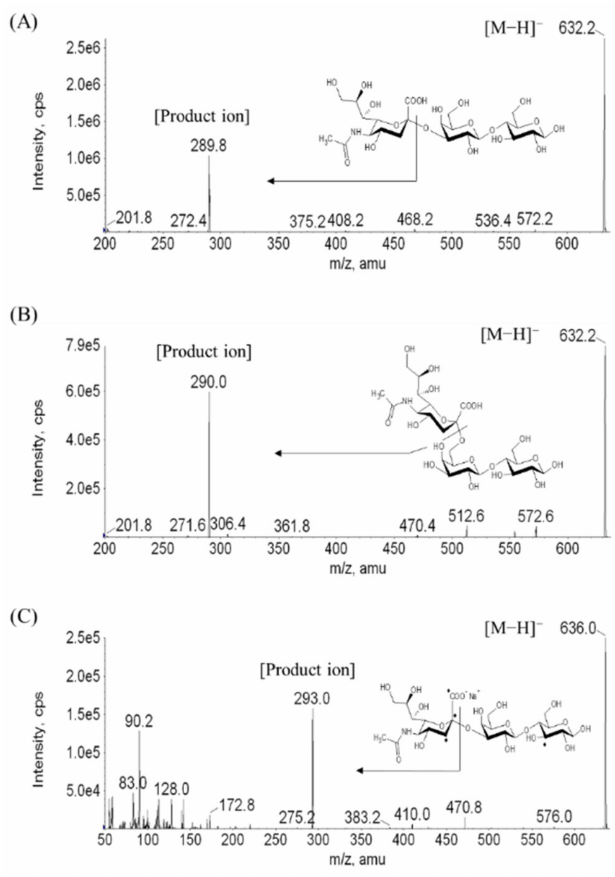
Figure 2. Molecular structure and product-ion scan spectra of ( A ) 3 (cid:48) -SL, ( B ) 6 (cid:48) -SL, and ( C ) internal standard (IS). Table 1. Selectivity for 3 (cid:48) -SL and 6 (cid:48)